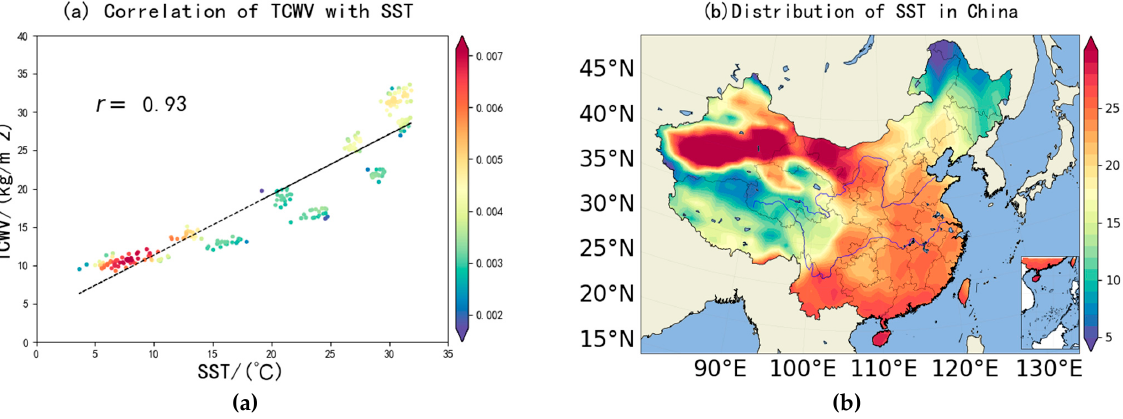
Figure 12. The relationship between TCWV and SST. ( a ) Correlation of TCWV with SST. ( b ) Distribution of SST in China.